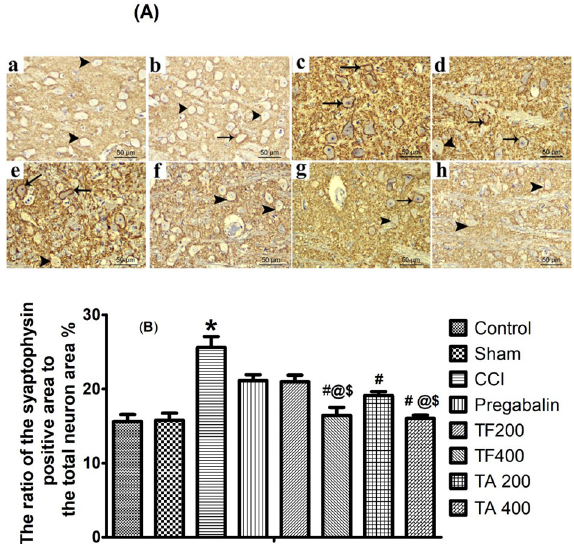
Figure 10. ( A ) Representative photomicrographs showing the expression of the synaptophysin in the neurons of sections in brain stem in different experimental groups. (a) control group; (b) sham group; (c) CCI group; (d) pregabalin group; (e) TF (p.o., 200 mg/kg); (f) TF (p.o., 400 mg/kg). (g) TA (p.o., 200 mg/kg); (h) TA (p.o., 400 mg/kg). Arrowhead indicating coarsely fine beaded reactivity at the neuron surface and arrow indicating dense bands of reactivity at the periphery of the neurons. Scale bar; 50 μm. ( B ) Bar chart showing the ratio of the synaptophysin positive reactivity on the surface of the neuron to the total area of the neuron in the brainstem sections of all experimental groups. Statistical analysis using one way ANOVA followed by Tukey post hoc test. Values are set to mean ± SE (n = 6). * Significant difference in comparison to the control group, p < 0.05 ; # Significant difference from the diseased group, p < 0.05; @ Significant difference compared to the pregabalin group, p < 0.05; $ Significant difference compared to the TF200 group, p <